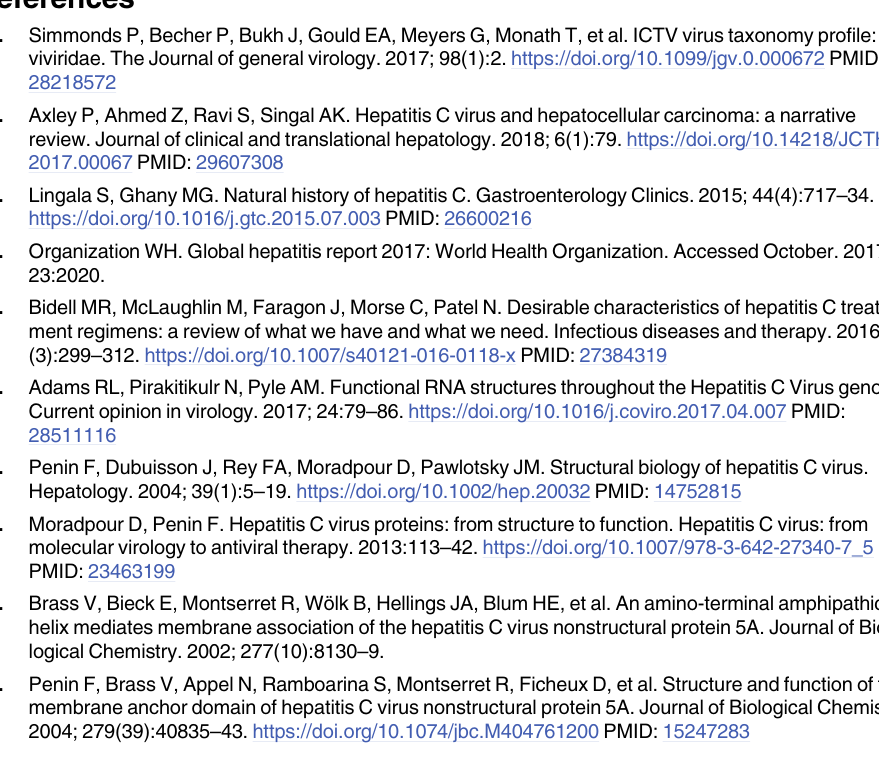
S1 Table. oligonucleotide sequence of primers used in this study.